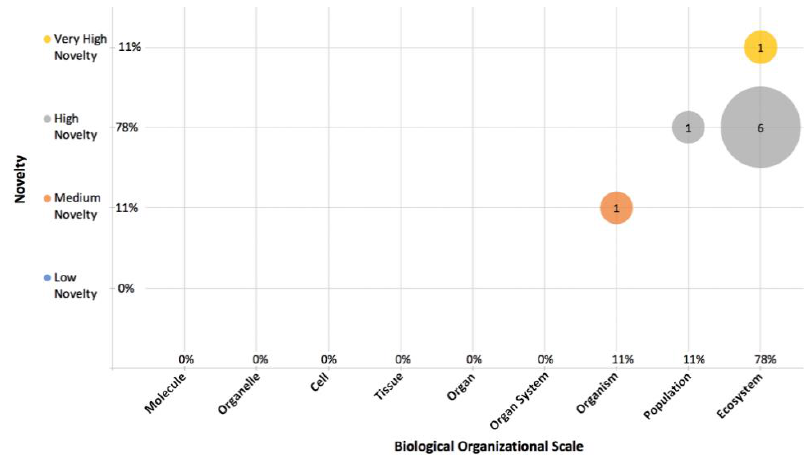
Figure 8. Novelty Distribution of Biomimetic Principles ( n =